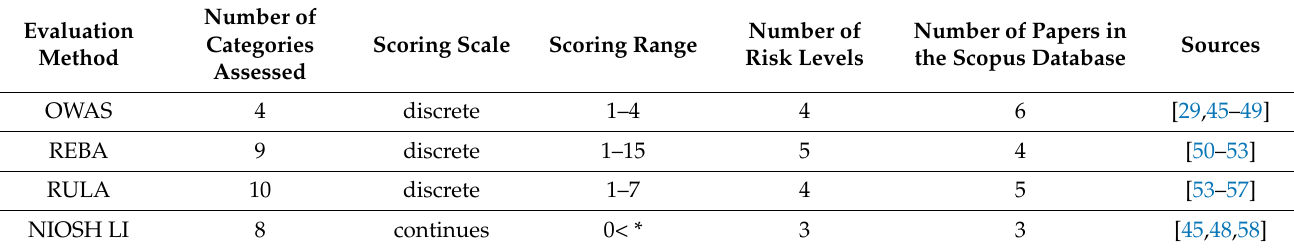
Table 1. Use of ergonomic evaluation methods in order